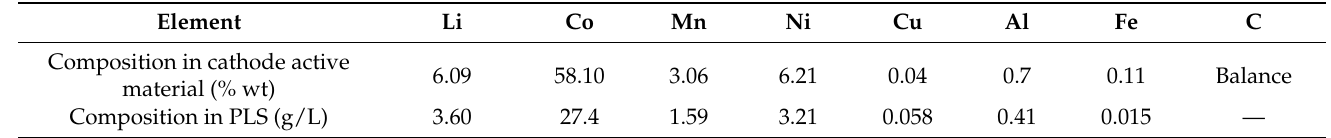
Table 2. Chemical composition of cathode active material of spent LIBs and pregnant leach solu- tion